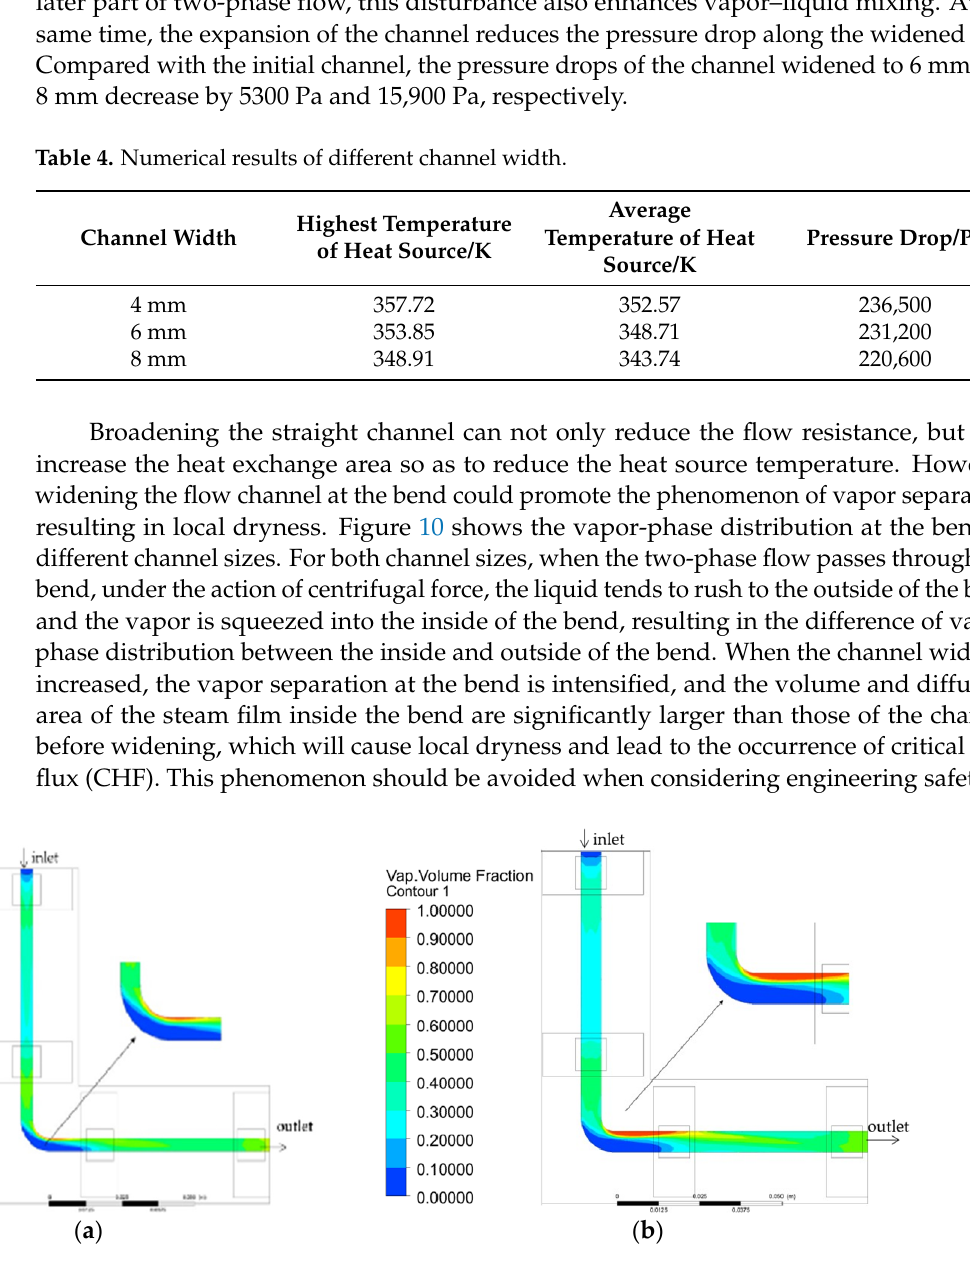
Figure 10. Vapor − phase distribution of di ff erent channel size; ( a ) 4 mm × 3 mm; ( b ) 6 mm × 3 mm. Figure 10. Vapor–phase distribution of different channel size; ( a ) 4 mm × 3 mm; ( b ) 6 mm × 3